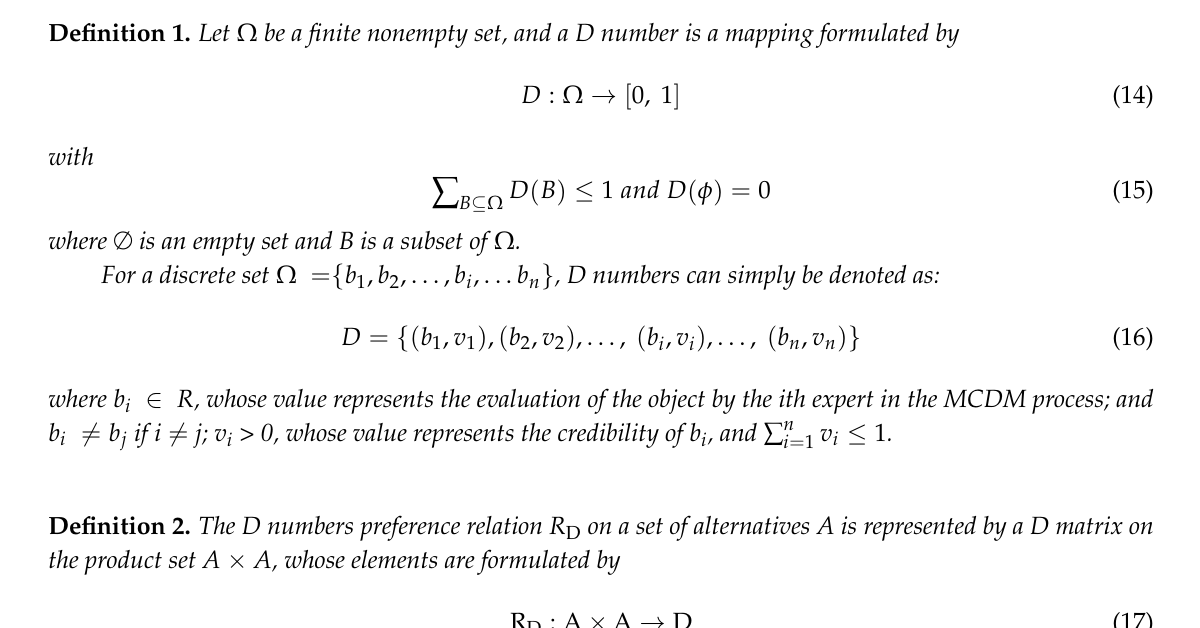
Figure 5. Pearson correlation matrix.